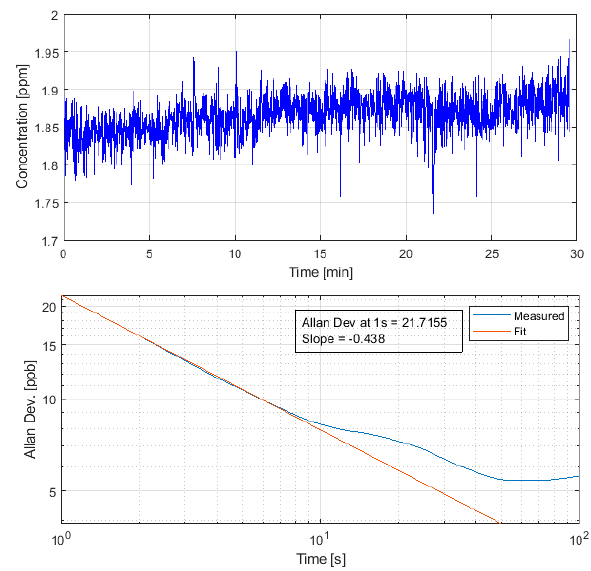
Figure 5. Allan deviation analyis of methane flight data from sUAS.